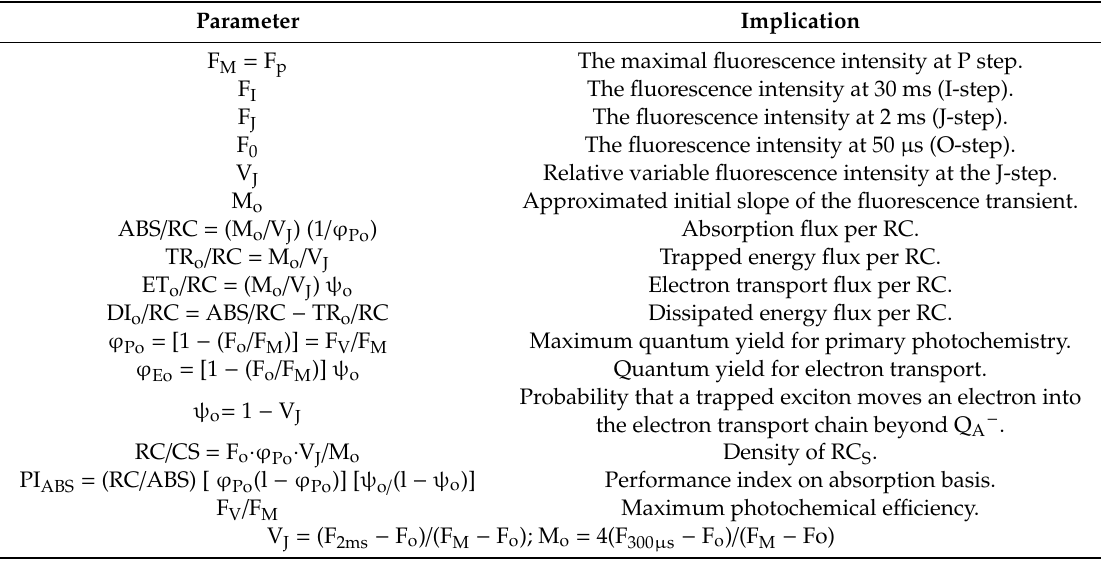
Table 1. Formulas and terms used in the